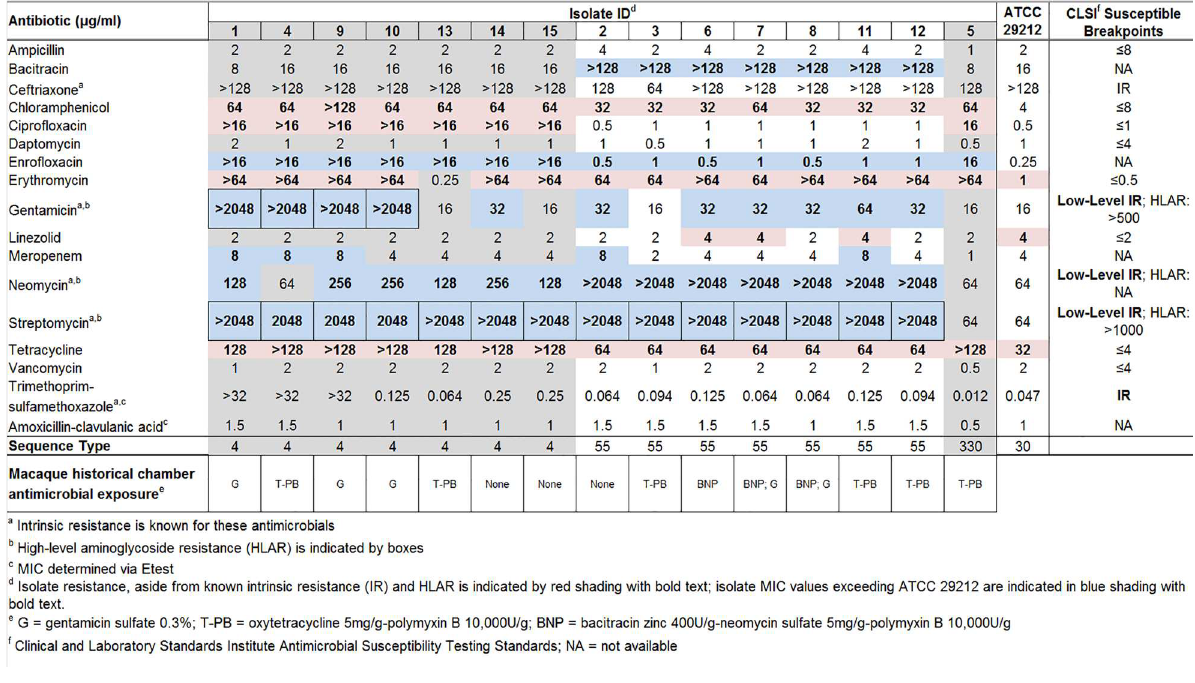
Fig 2. Minimum Inhibitory Concentration (MIC) via Broth Microdilution and Etest Results for Macaque Chamber E . faecalis Isolates as Compared to ATCC E . faecalis 29212. Sequencetypes and historicalrecordingchamberantimicrobial exposureare indicatedfor each macaqueisolate.